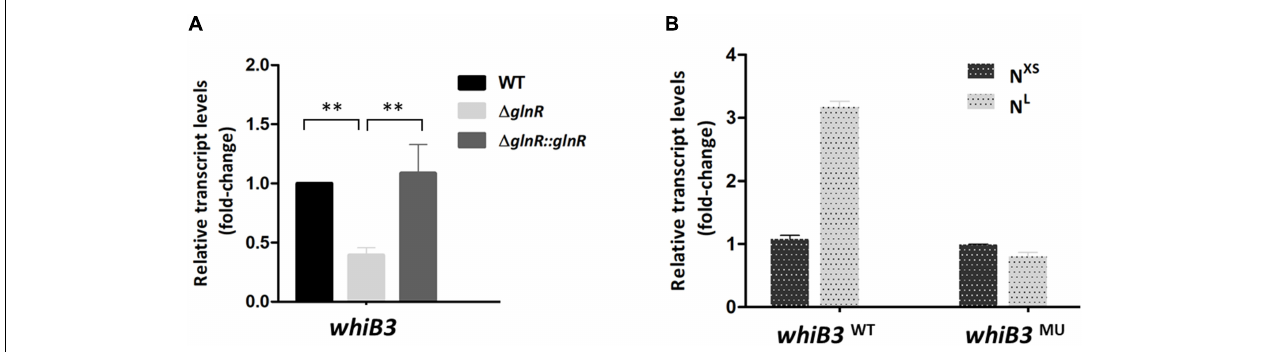
FIGURE 2 | The whiB3 expression is directly controlled by GlnR. (A) The whiB3 transcription levels in Mycobacterium smegmatis WT, (cid:49) glnR and (cid:49) glnR :: glnR strains grown in N L medium till the middle exponential phase. Fold change represented the expression level compared to the whiB3 expression in WT strain. (B) The whiB3 transcription levels in M. smegmatis whiB3 WT and whiB3 MU strains grown in N XS /N L condition. Fold change represented the whiB3 transcription level compared to whiB3 WT strains grown in the N XS condition. The error bars showed standard deviations from three independent experiments. ∗∗ P < 0.01.